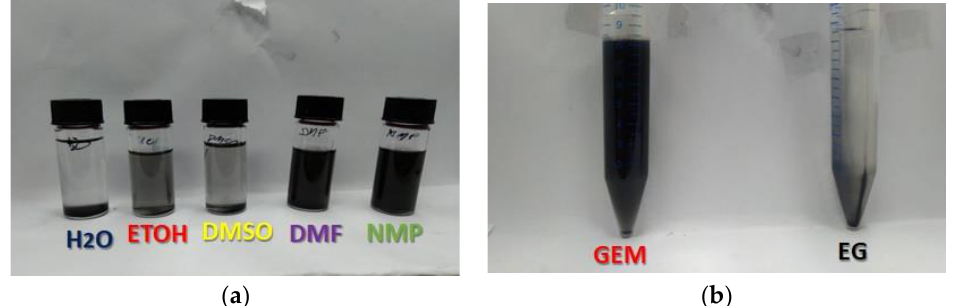
Figure 8. Graphene dispersion in a polar solvent ( a ). Comparison of a solution in ethanol of Graphene diethyl maleate (GEM) and Graphene (G). ( b ) Direct use of graphene in ethanol results in complete precipitation after 24 h (right) while a stable graphene dispersion in ethanol is obtained the solution is still stable after a year.